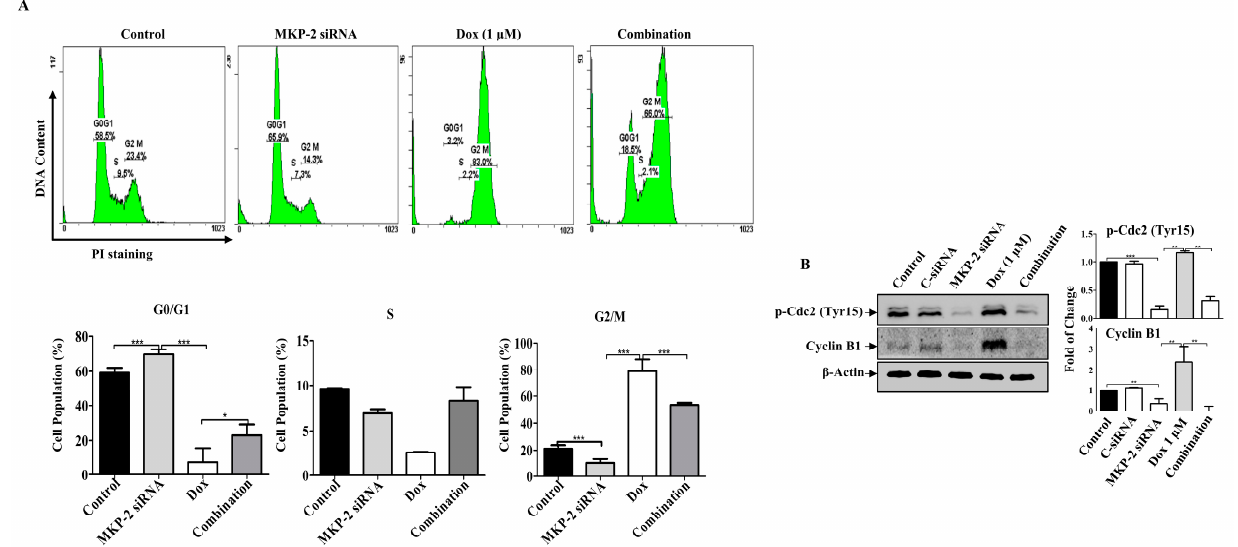
Figure 4. MKP-2 Silencing Promotes Cell Cycle Arrest in Breast Cancer Cells. MDA-MB-231 cells were transfected with MKP-2 siRNA (10 nM) for 72 h and then treated with the indicated concentrations of Dox for 24 h. ( A ) Representative cell cycle distribution was analyzed by flow cytometry. ( B ) Cell lysates were prepared, separated by SDS-PAGE and assessed for Cyclin B1 and p-Cdc2 (Tyr15). Each value represents the mean ± S.E.M of three independent experiments. * p ≤ 0.05, ** p ≤ 0.01, *** p ≤ 0.001, compared with the correspondent control.